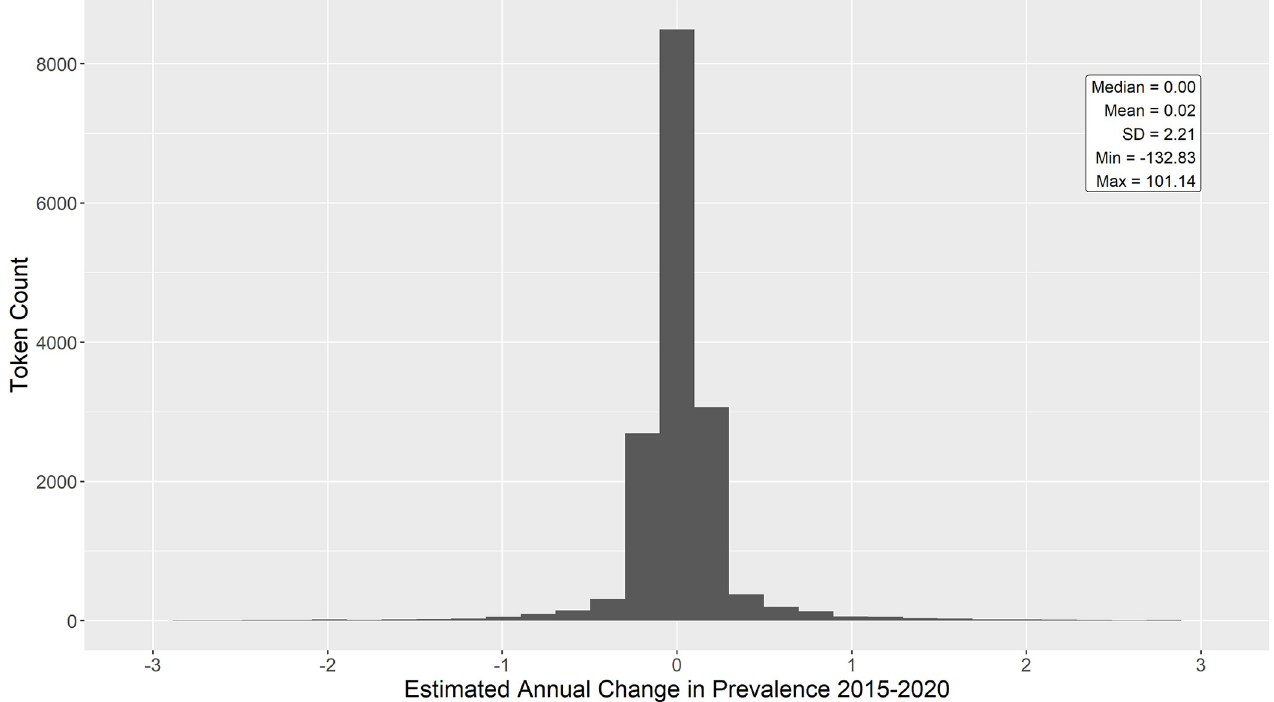
Fig 3. Distribution of estimated annual change in prevalence for all unique tokens within the longitudinal sample. Prevalence is stable (i.e. zero change) for many tokens. Note from the min and max annotations that extreme values are present in the data but not pictured here. See Tables 4 and 5 for illustration. Fig 3 contains a histogram of slopes for all tokens in the longitudinal data from 2015–2020.